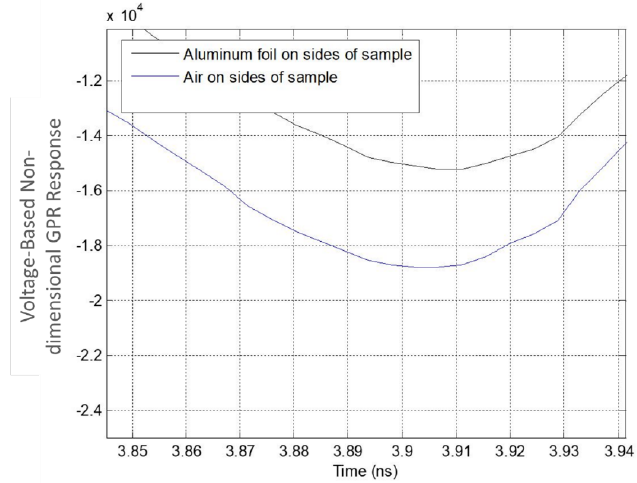
Figure 18. Zoomed in view of the comparison of isolated reflection differences from scans obtain with and without aluminum foil wrapped around the sides of the specimen.